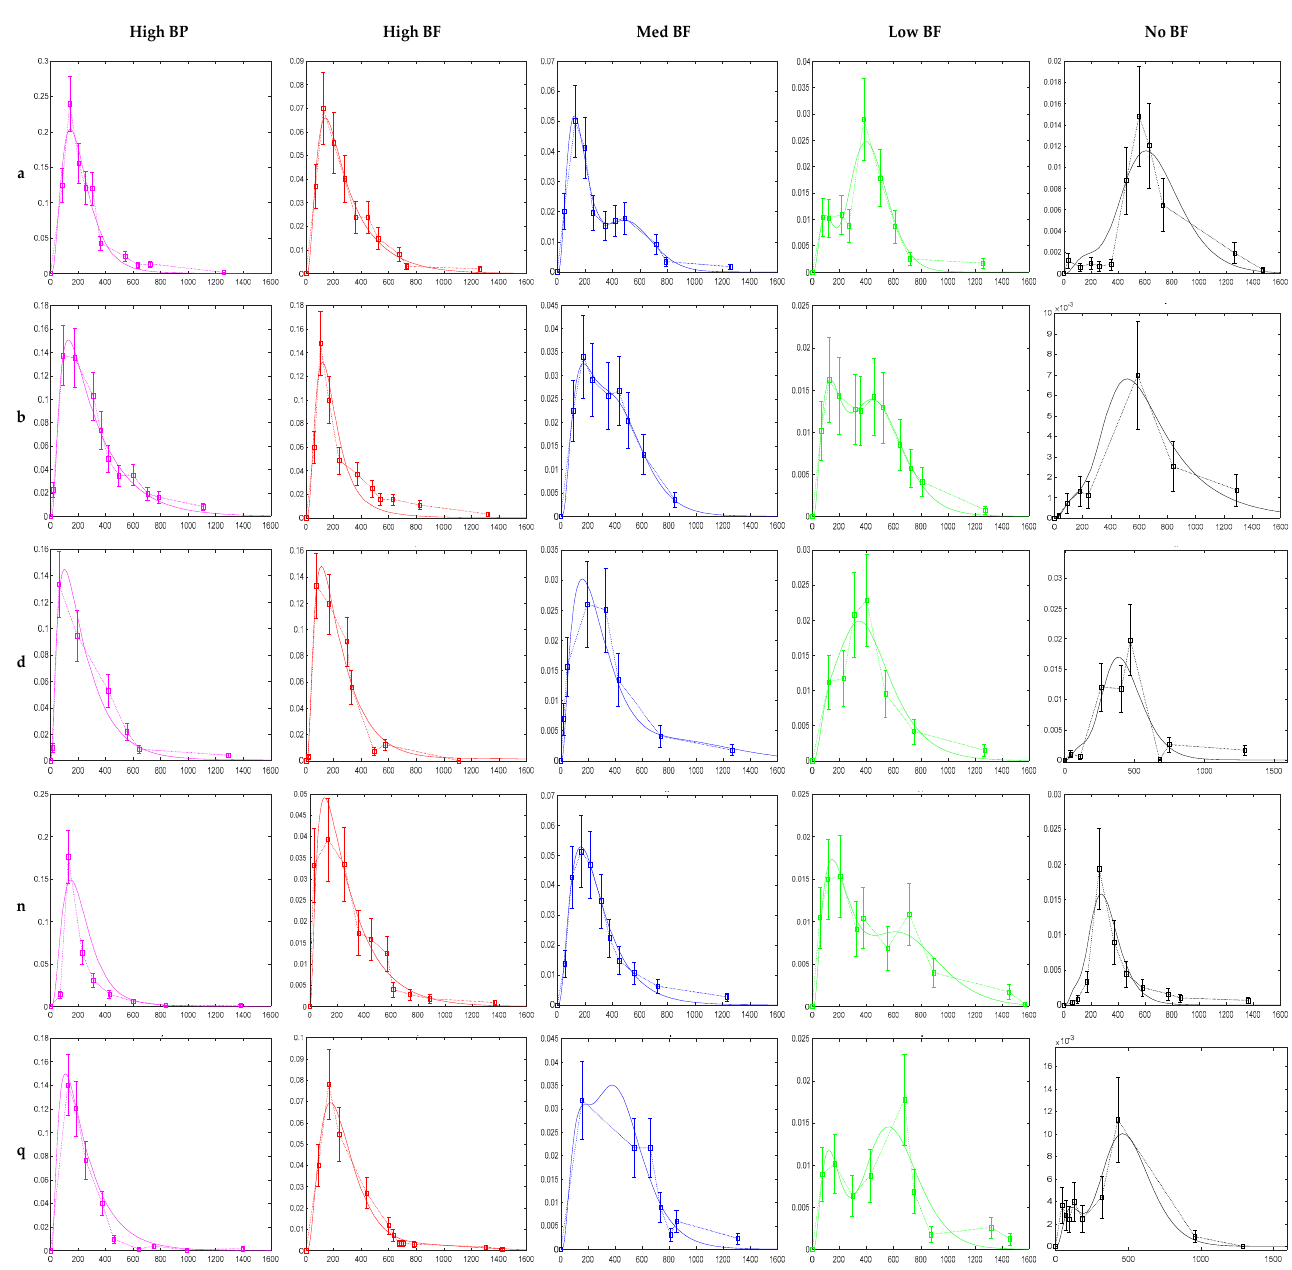
Figure 4. Model fittings for participants a, b, d, n, q. X and Y axis for each graph is, time (min) and sulforaphane conjugate excretion rate (µmol/min), respectively. Experimental data are the square bullets, and the solid lines are the model fits. Error bars represent potential experimental error from the analytical techniques used by Oliviero et al. to measure the amounts of ITC conjugates in urine. All participant model fittings are in Figure S1: Model Fittings Results for All Participants in the Supplementary Files.